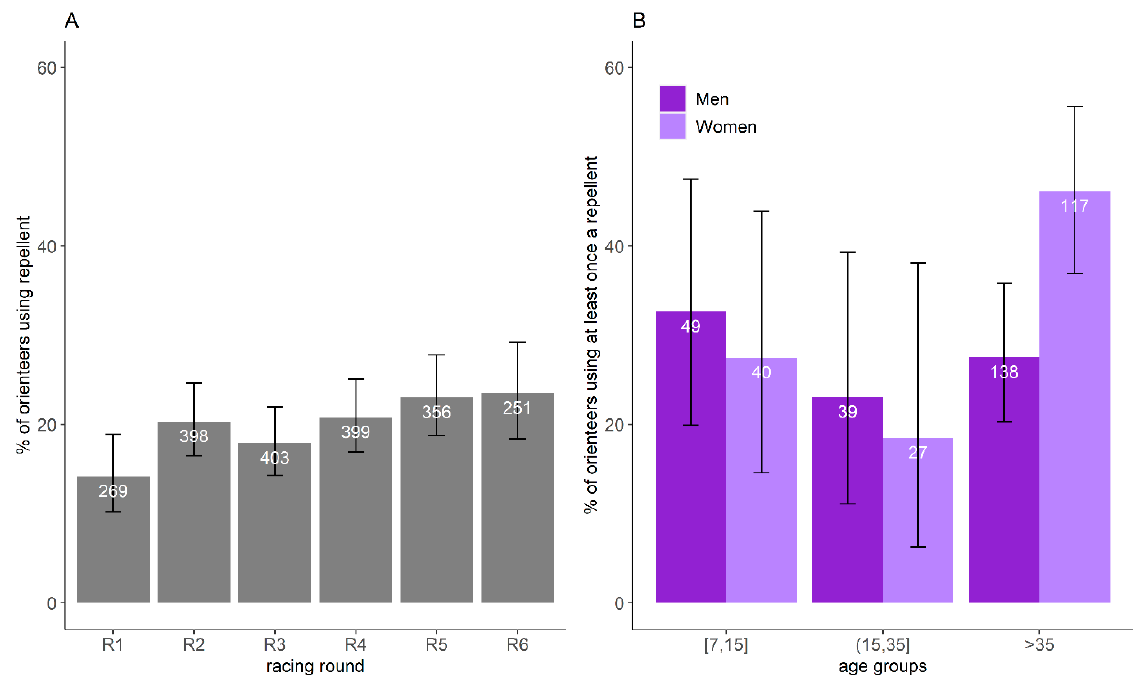
Figure 5. Proportion of orienteers using repellent and its confidence interval of 95% per racing round ( A ) and per age group and gender ( B ), estimated by the restricted banner dataset. The number represents the number of orienteers reporting information on repellent use in the restricted banner dataset.